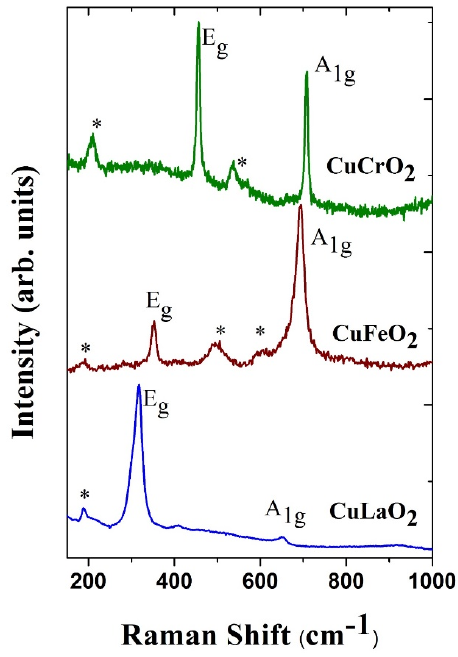
Figure 4. Raman spectra of as-synthesized CuLaO 2 , CuFeO 2 and CuCrO 2 ,showing two allowed Raman modes, a few weak modes shown by asterisks are disorder induced non-zone centre modes.